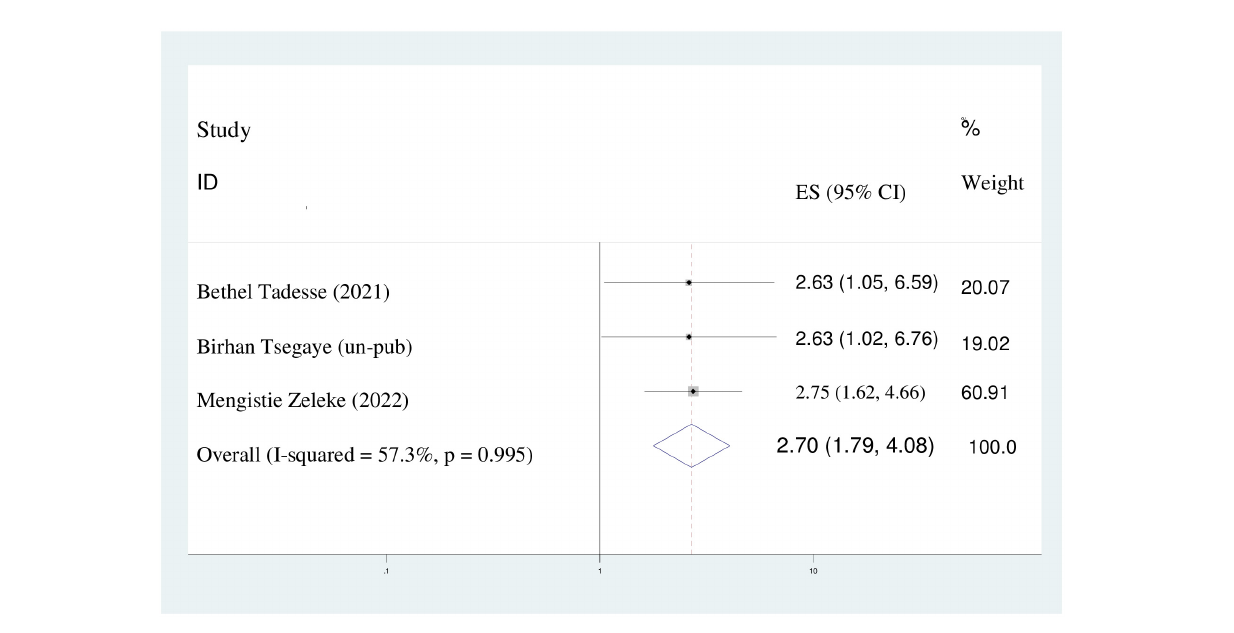
FIGURE8 The pooled odds ratio displaying the association of instrumental delivery with disrespect and abuse of women.